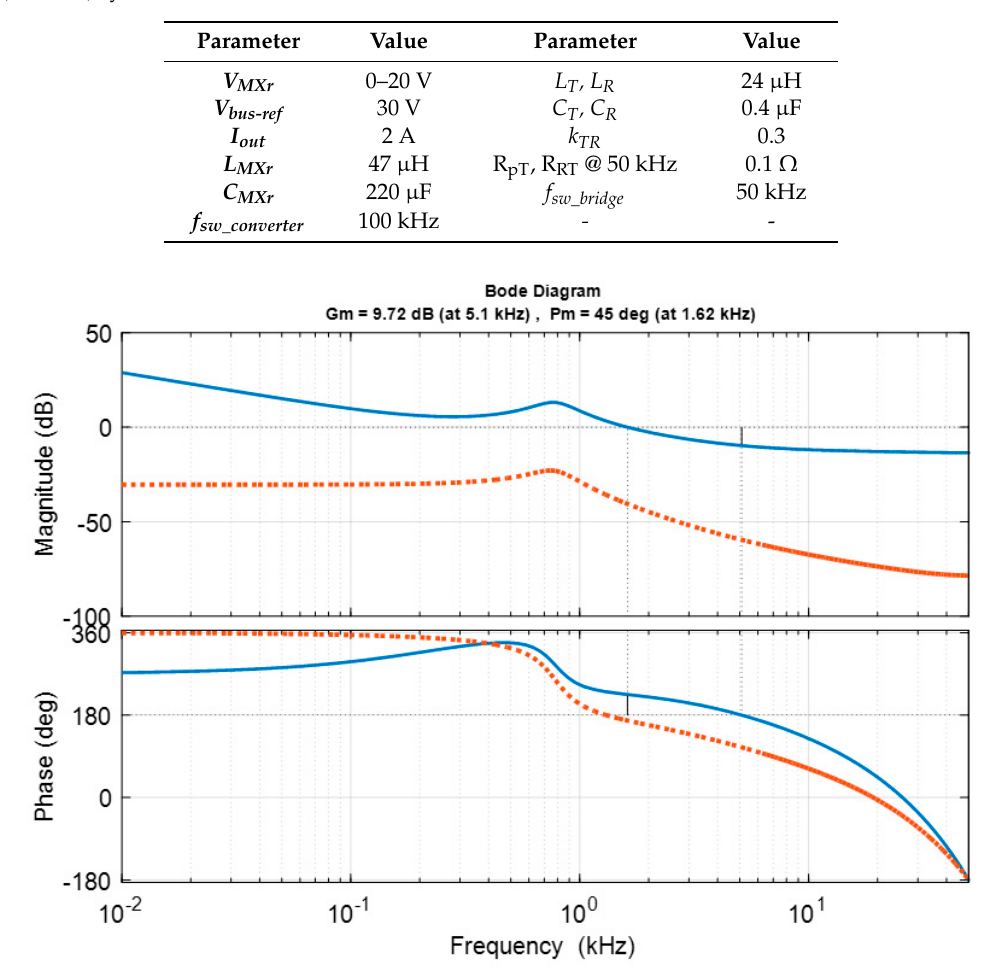
Figure 6. The bode plot of the uncompensated (red-dashed curve) and compensated (blue-solid curve) battery module voltage control loop gain.